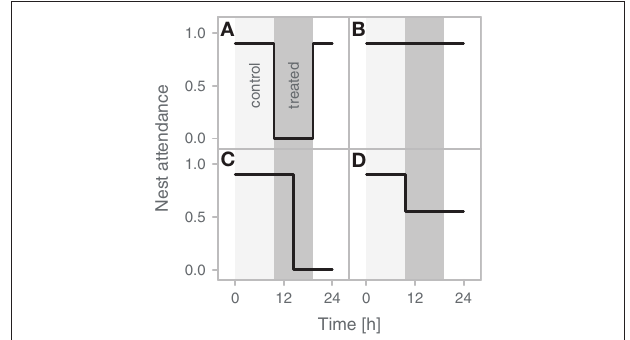
FIGURE 1 | Possible compensation strategies for temporal absence of a partner. Zero on the x-axis represents the time when a parent is experimentally removed. The light gray area represents the typical incubation bout of the focal parent, i.e., the control period. The dark gray area represents the removed parent’s expected incubation bout, i.e., the treated period. The black line indicates the change in nest attendance over time. (A) No compensation—an individual leaves the nest at the end of its incubation bout and returns when its next bout is expected to start—reflects a decision by the bird not to change its investment in response to the absence of its partner, or a lack of knowledge about the partner’s absence (the bird may simply leave to forage at the end of its bout, as it typically does, without noticing the partner’s absence). (B) Full compensation—an individual continuously incubating for the entire expected bout of its partner—arises if the incubating bird waits for the partner to return before ending its own bout, assuming that it has not yet reached its energetic limits. (C) Partial compensation—an individual continues incubating, but gives up and leaves at a certain point in time (e.g., when its energy stores are depleted) so that it goes from full to no compensation within its partner’s “bout.” (D) Partial compensation—an individual continues incubating, but with lower nest attendance as it leaves the nest for short feeding bouts, that is, it starts behaving like a species that incubates uniparentally ( Bulla et al.,